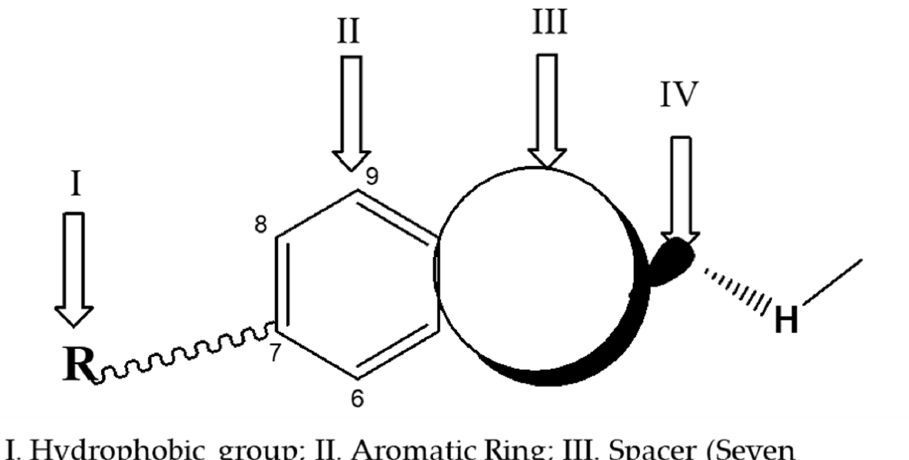
Figure 3. Calone 1951 olphactophore model and